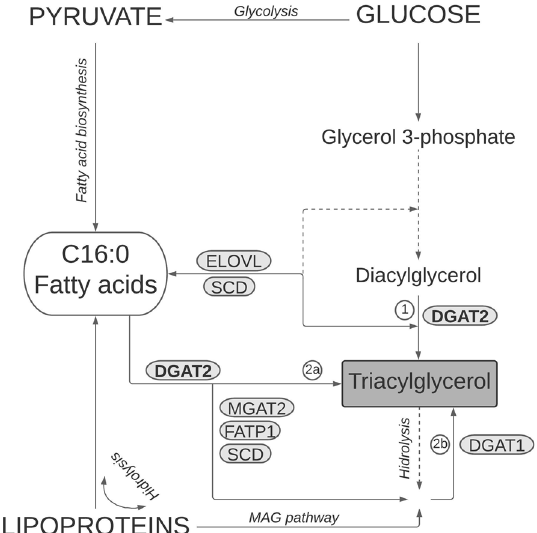
Figure 1. The role of DGAT2 in the synthesis pathway of triacylglycerol. Triacylglycerol is (1) synthesized de novo by sequential addition of fatty acyl moieties to a glycerol 3-phosphate (the G3P pathway) or (2) formed through the re-esterification of partial glycerides that results from either the hidrolysis of pre-existing triacylglycerol or via the monoacylglycerol (MAG) pathway. De novo transformation of diacylglycerol to triacylglycerol is catalyzed by DGAT2 (1) but re-esterification of partial glycerides is done by either DGAT2 (2a) or DGAT1 (2b). However, while DGAT1 specifically incorporates pre-formed fatty acids, DGAT2, which is able to form protein complexes with MGAT2, FATP1 and SCD, can use both endogenous and pre-formed fatty acids as substrates. DGAT1 diacylglycerol O -acyltransferase 1, DGAT2 diacylglycerol O -acyltransferase 2, ELOVL